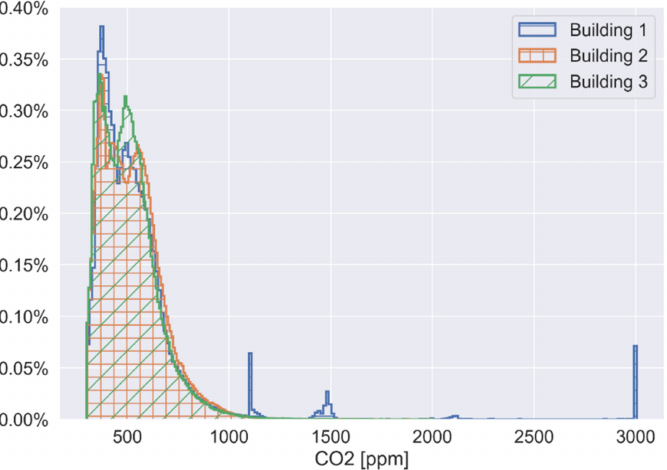
Figure 31. Probability density of CO 2 concentration from all apartments over 12 months.